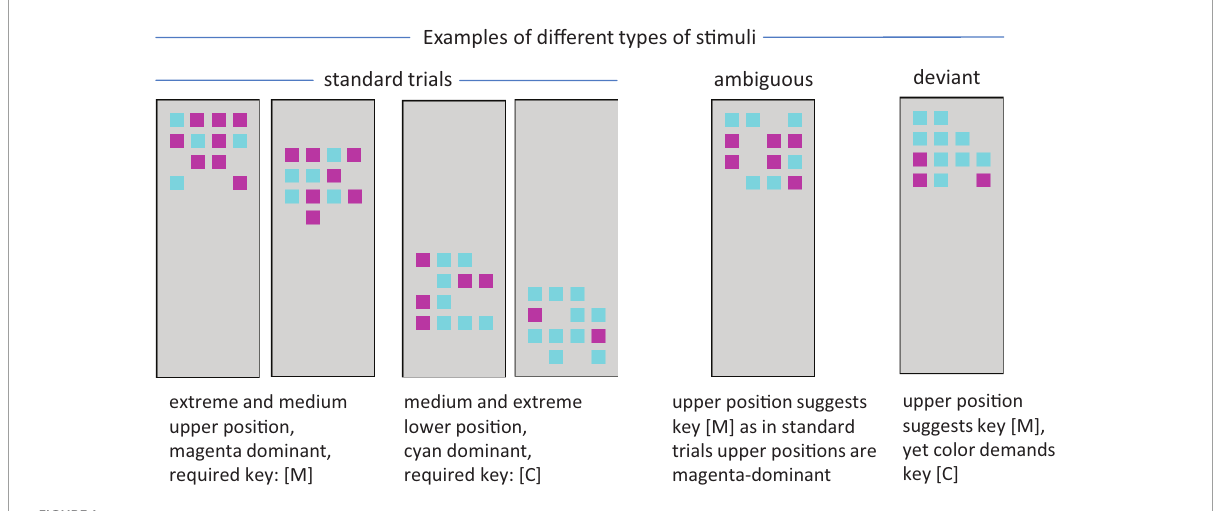
FIGURE1 Examples of stimuli varying stimulus position and ratio of cyan and magenta squares. In standard trials, dominantly magenta arrays were always placed in the upper part of the reference frame and dominantly cyan stimuli always in the lower part. For deviant trials, the color-position relationship is reverse. For ambiguous trials, there is no dominant